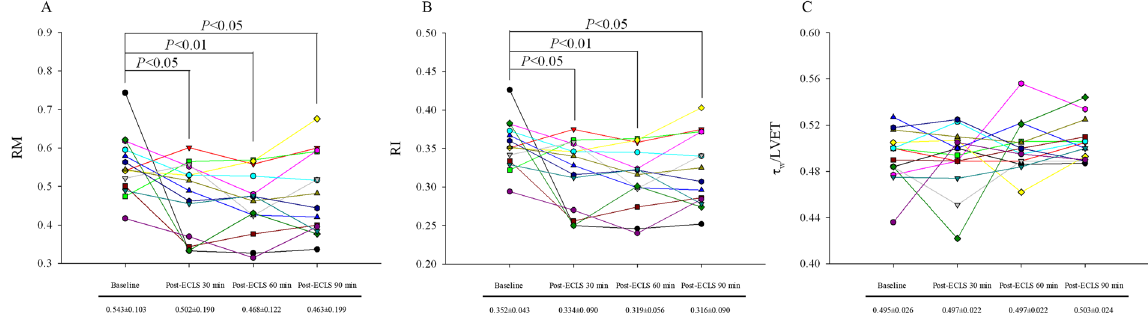
Figure 2. Effects of ECLS on the changes of RM ( A ), RI ( B ), and τ w /LVET ( C ). Each line represents a different rat in this study. RM and RI show downward trends, which decreased markedly after ECLS treatment. The τ w / LVET ratio tended to slightly increase after ECLS treatment. RI = wave reflection index; RM = wave reflection magnitude; τ w /LVET = the ratio of wave transit time to left ventricular ejection period.